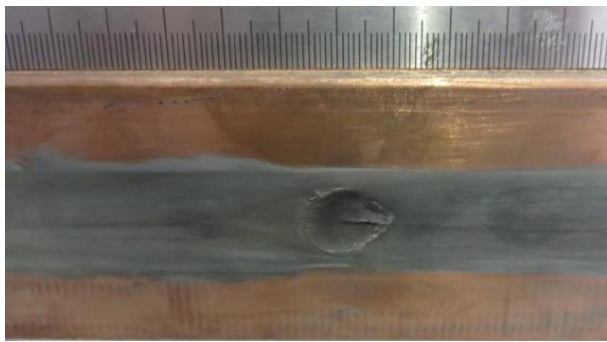
Figure 12. A part of the rail surface containing a gouge crater.